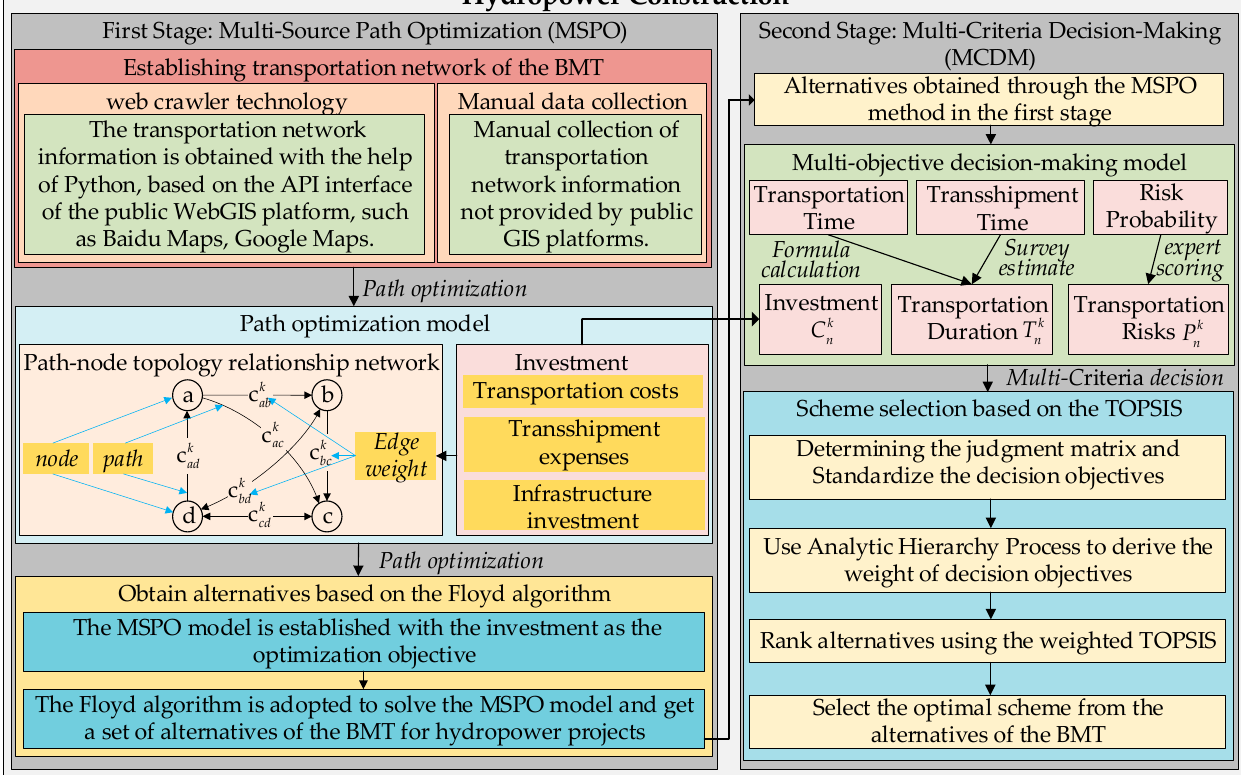
Figure 2. The structure of the TDM based on WebGIS.